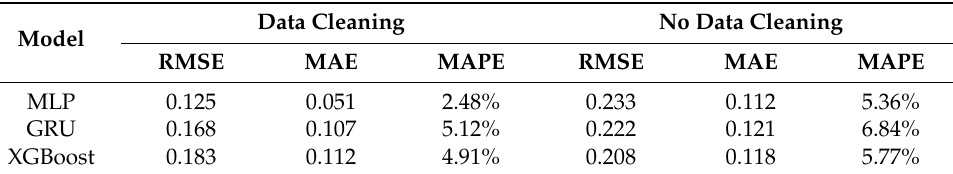
Table 3. The statistical results under different circumstances.